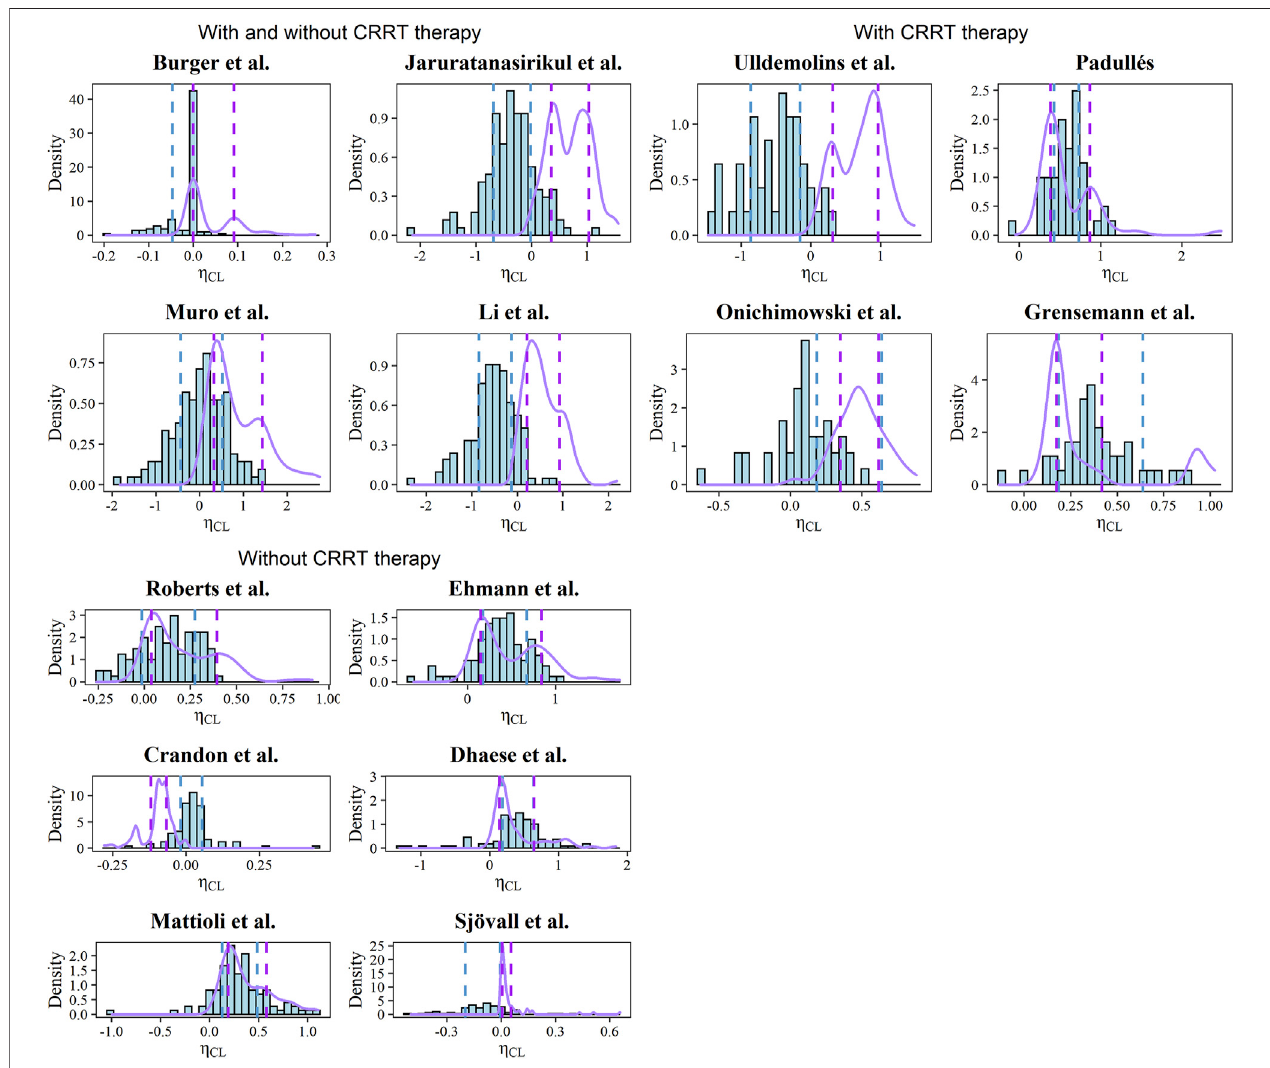
FIGURE3| Histograms ofEBEs fortheCLofeach model. Thepurplesolidlines represent thedensity ofsimulatedCL.Theblue andpurple dashed linerepresents the 20th and 80th percentiles of calculated and simulated EBEs, respectively.